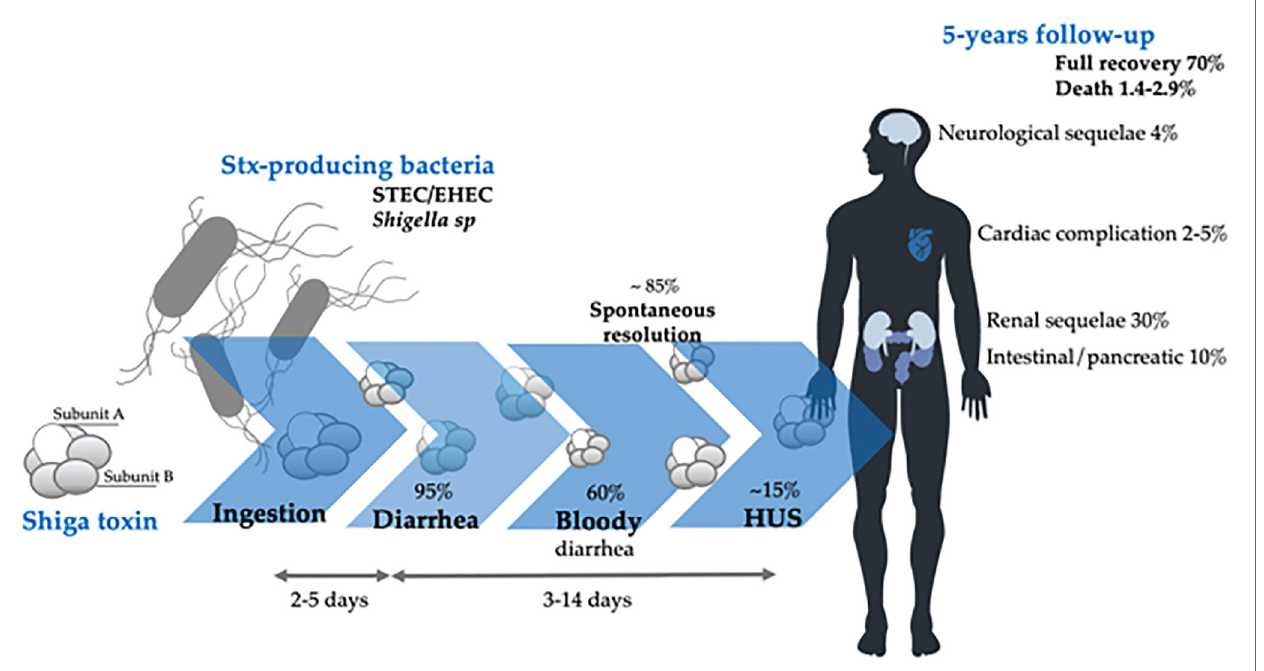
FIGURE 1 | Clinical course and main outcomes of Stx-producing bacterial infection. Modi fi ed from (Bruyand et al.,